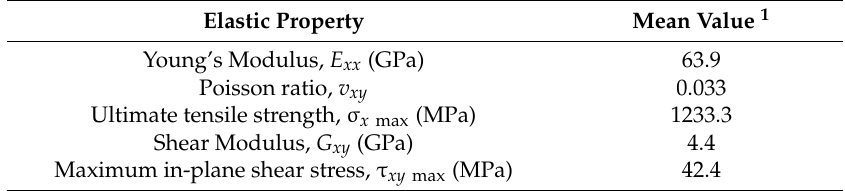
Table 4. Mechanical properties of AS4 Spreadtow-EPOLAM 2019 CFRP used in H2 cowling.